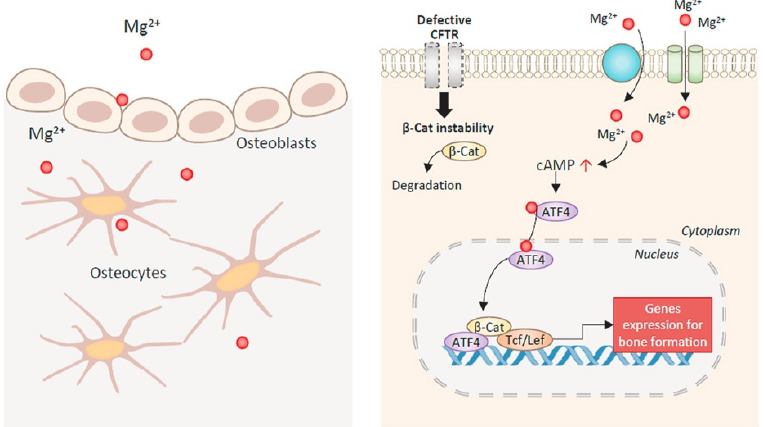
Figure 2. The effect of magnesium on bone formation with CFTR deficiency. Magnesium ions enter bone-forming cells through Mg 2+ channels or transporters. Mg 2+ induces the cAMP increase and the activation of transcription factors, ATF4 and β -catenin ( β -Cat), rescuing CFTR-deficiency-impaired Wnt/ β -catenin signaling to promote bone formation. Reprinted from ref. [45].